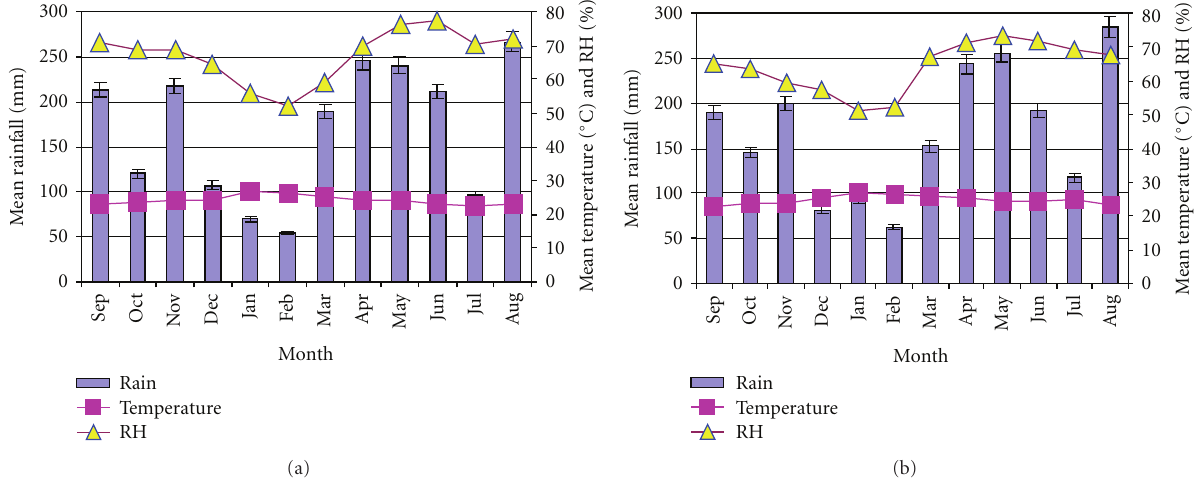
Figure 5: (a) Rainfall, temperature, and relative humidity in the mixed indigenous forest (Isecheno). (b) Rainfall, temperature, and relative humidity in the indigenous forest